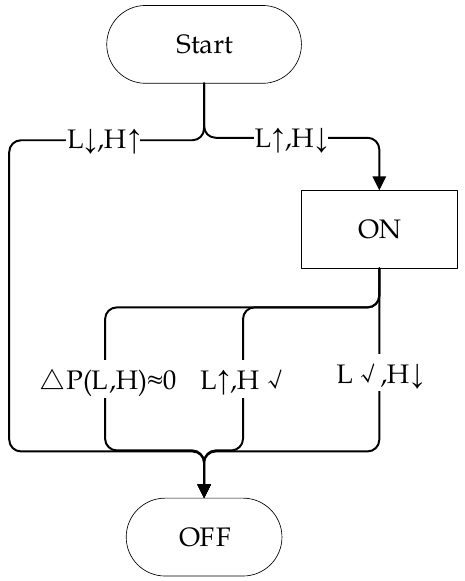
Figure 4. Action of solenoid valves in interconnected mode activation by judging different pressure condition in two-side of interconnected air suspension. In which, Δ P (L, H) represents the pressure difference between the high- and low-pressure sides; L represents low-pressure side; H represents high-pressure; ↑ represents increasing pressure; ↓ represents decreasing pressure; √ represents reaching targeted pressure.